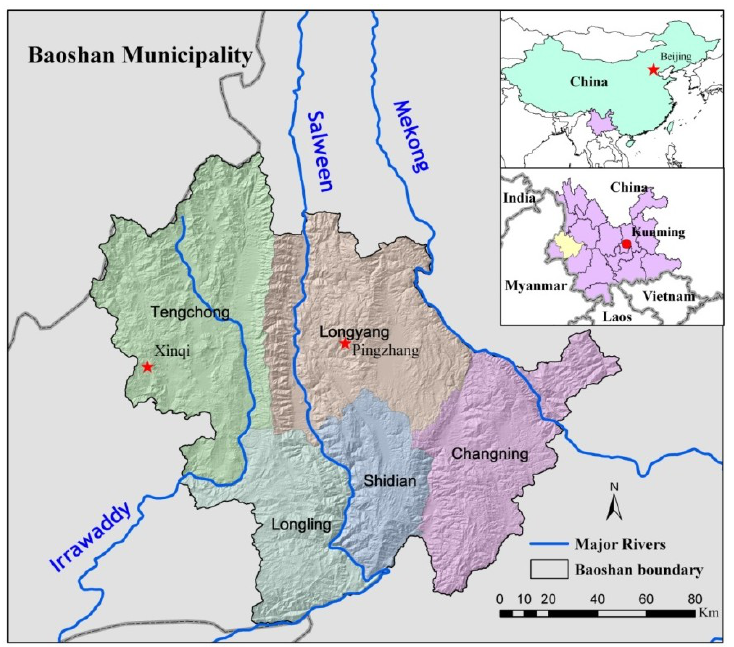
Figure 1. The location of the study